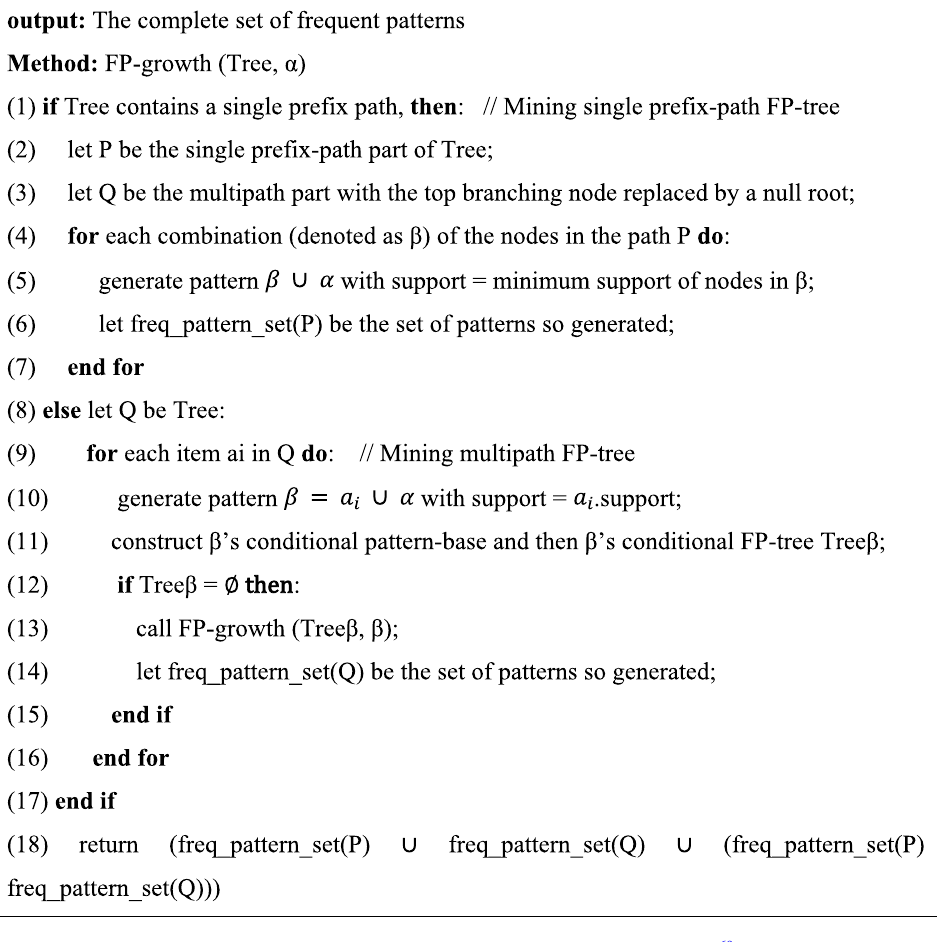
Table 7. Pseudocode of frequent itemset generation step in FP-Growth algorithm 69